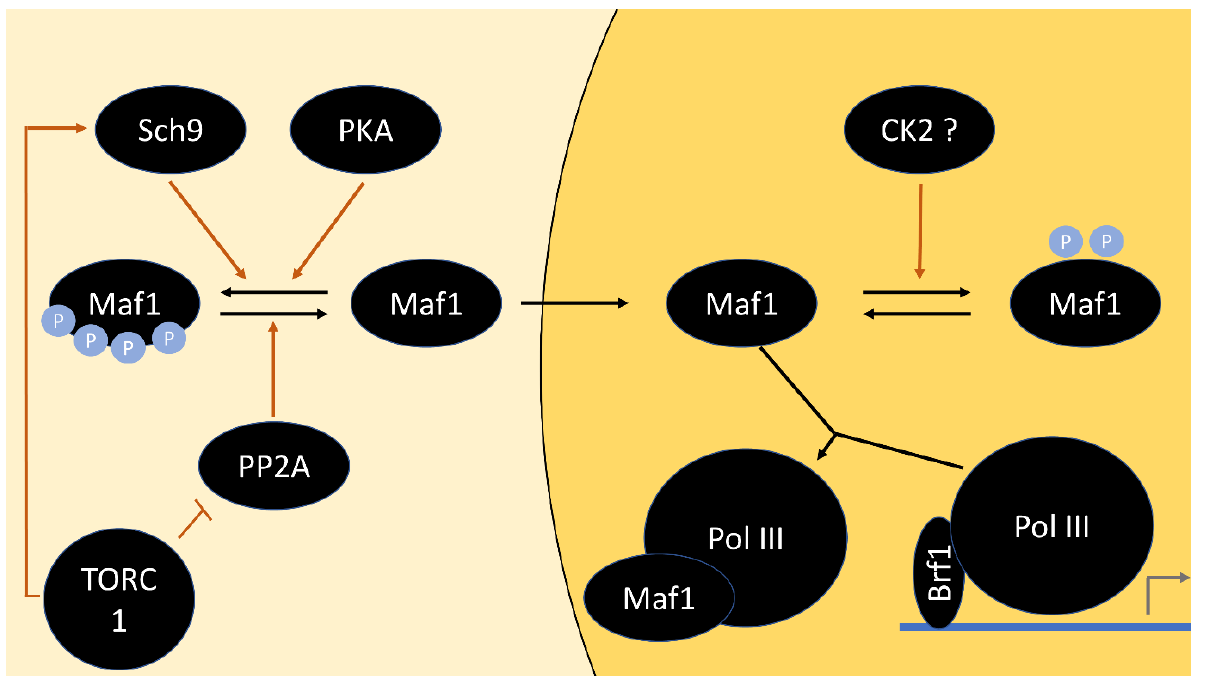
Figure 3. Model of the regulation of Pol III transcription factor Maf1. Maf1 is phosphorylated by Sch9 and PKA to prevent its nuclear localization. This is counteracted by dephosphorylation by PP2A. Unphosphorylated Maf1 translocates to the nucleus and binds Pol III in a manner that prevents association with the transcriptional activator Bfr1, and therefore impedes transcription initiation. Possibly, phosphorylation of Maf1 on sites other than the PKA and Sch9 sites, potentially by CK2, hinders Maf1 association with Pol III. The subcellular locations at which Maf1 phosphorylation and dephosphorylation take place are unknown and may differ from the ones shown).